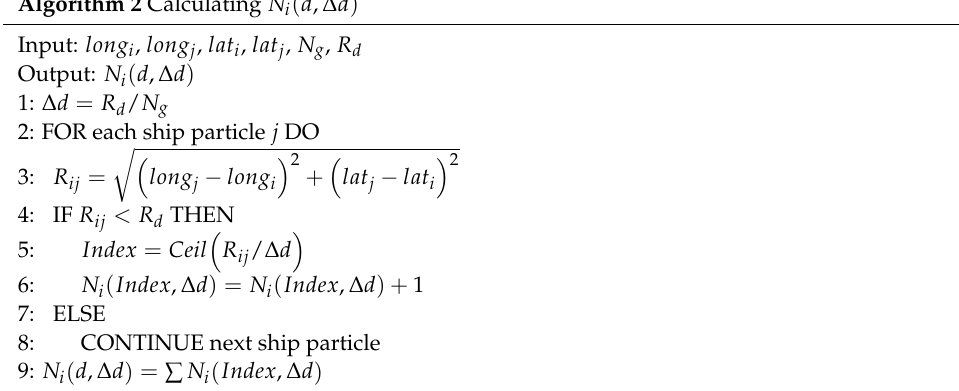
Algorithm 2 Calculating N i ( d , ∆ d